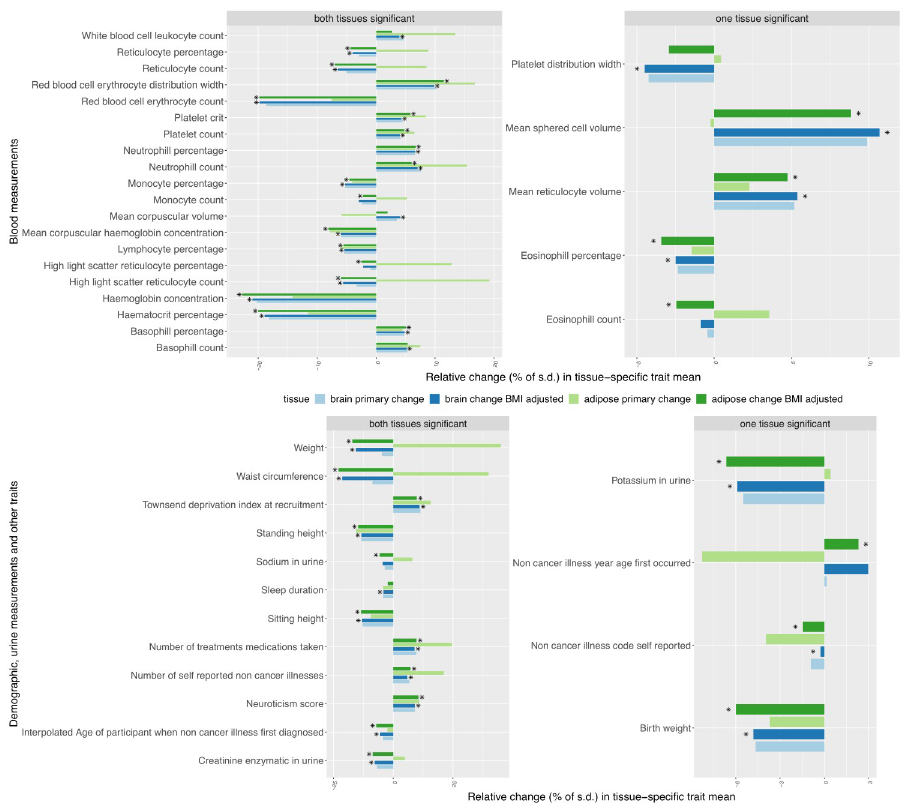
Fig 5. Percentage of tissue-specific relative change of the quantitative traits that were differentially distributed between the individuals assigned to a tissue-specific subtype of BMI and the remaining population. Traits in the left panels are primarily heterogeneous for both tissue-specific groups and traits in the right panels are heterogenous for one tissue-specific group. We measure the tissue-specific relative change of a trait by: tissue specific mean (cid:0) remaining population mean � 100 , where the tissue-specific mean is computed only in the individuals population s : d : with the corresponding tissue-specific subtype. The same measure is calculated for a trait residual obtained after adjusting for BMI to quantify the tissue-specific relative change of the trait after BMI adjustment. The faded green (or blue) bar presents primary adipose (or brain) tissue-specific relative change of a trait compared to the remaining population. The dark green (or blue) bar presents the BMI-adjusted adipose (or brain) specific relative change of a trait. Each trait listed here was found to be differentially distributed between at least one of the adipose or brain specific groups and the remaining population after BMI adjustment. For each trait, the asterisk mark attached to the bars indicates which tissue-specific group remains significantly heterogeneous after BMI